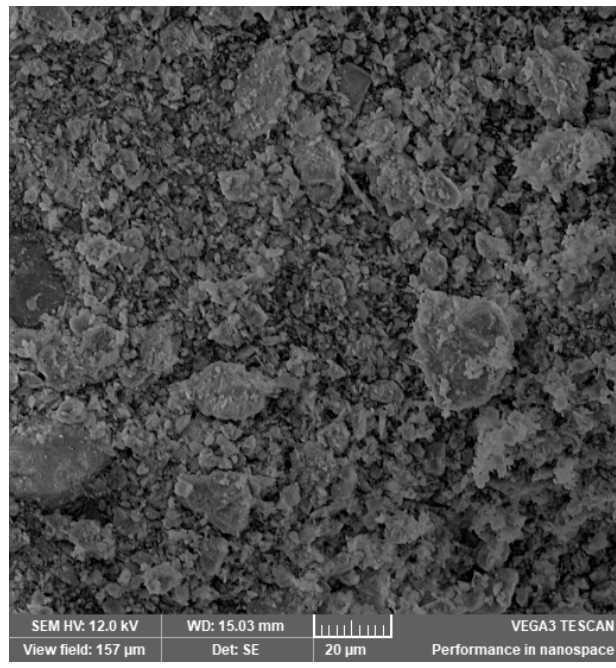
Figure 2. The SEM analysis of the initial zeolite sample.